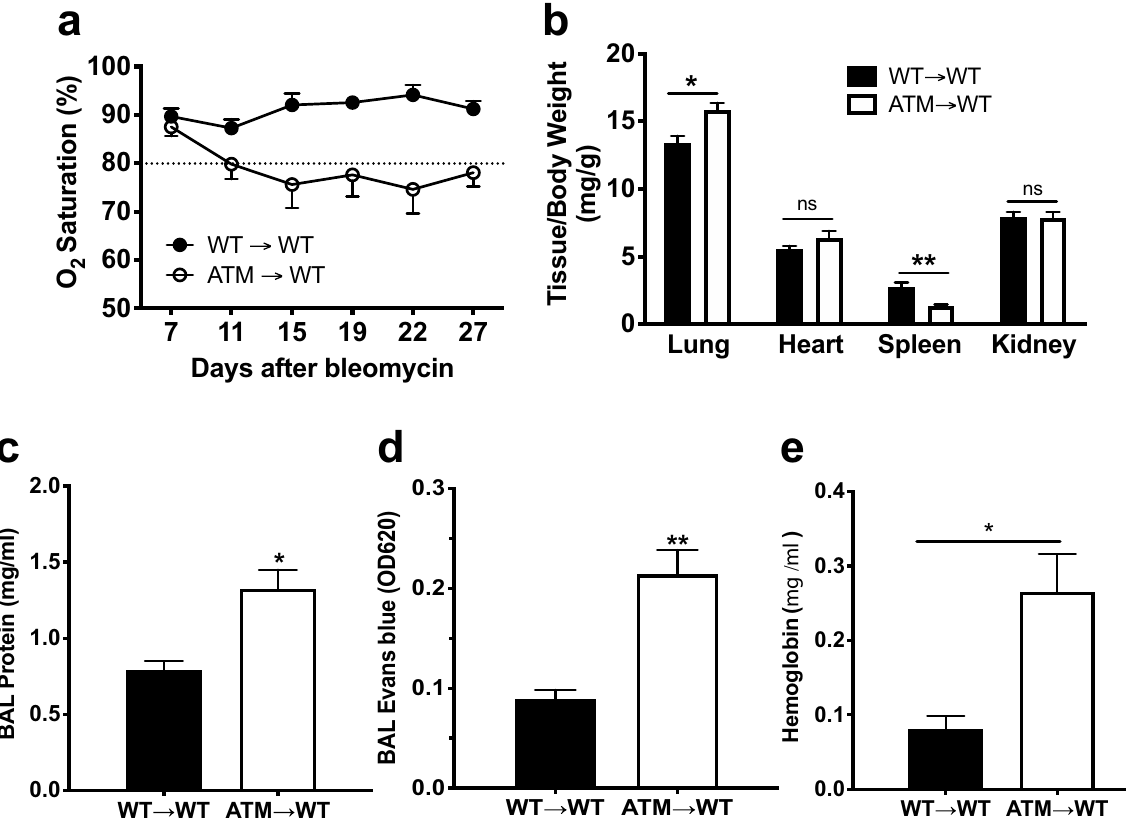
Figure 3. Transplantation of ATM-deficient bone marrow recapitulates acute lung injury phenotypes in chimeric mice. All experiments were performed on lethally irradiated WT recipients of WT (black bars, WT → WT) or ATM ∆/∆ (white bars, ATM → WT) bone marrow. Chimeric mice were bleomycin